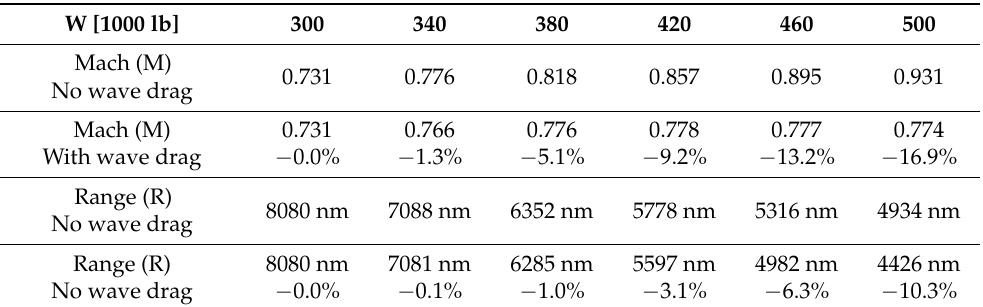
Table 5. Weight-dependence of maximum range and maximum-range airspeed, for both cases, with and without wave drag (including/excluding wave drag).